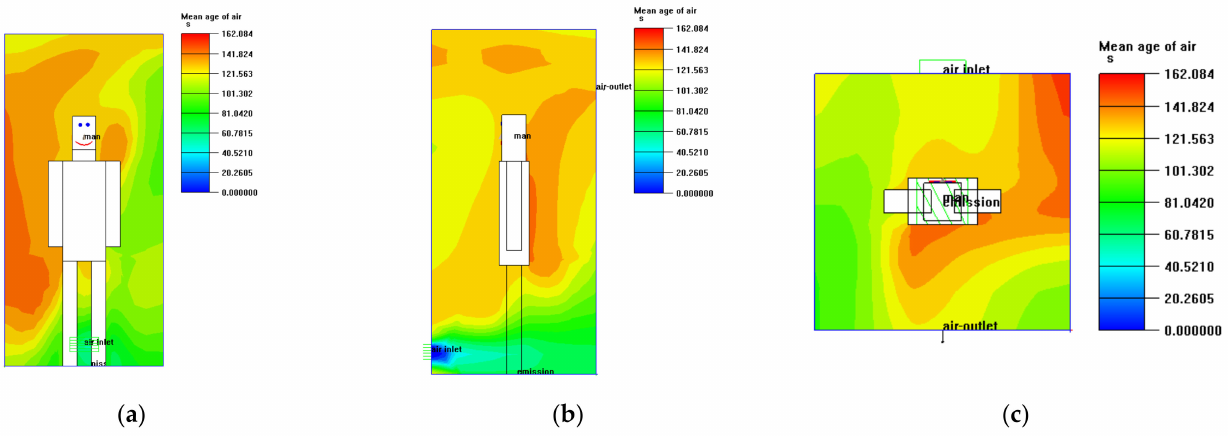
Figure 11. Air age distribution at ( a ) Z = 0.55 m, ( b ) X = 0.55 m, and ( c ) Y = 1.1 m.